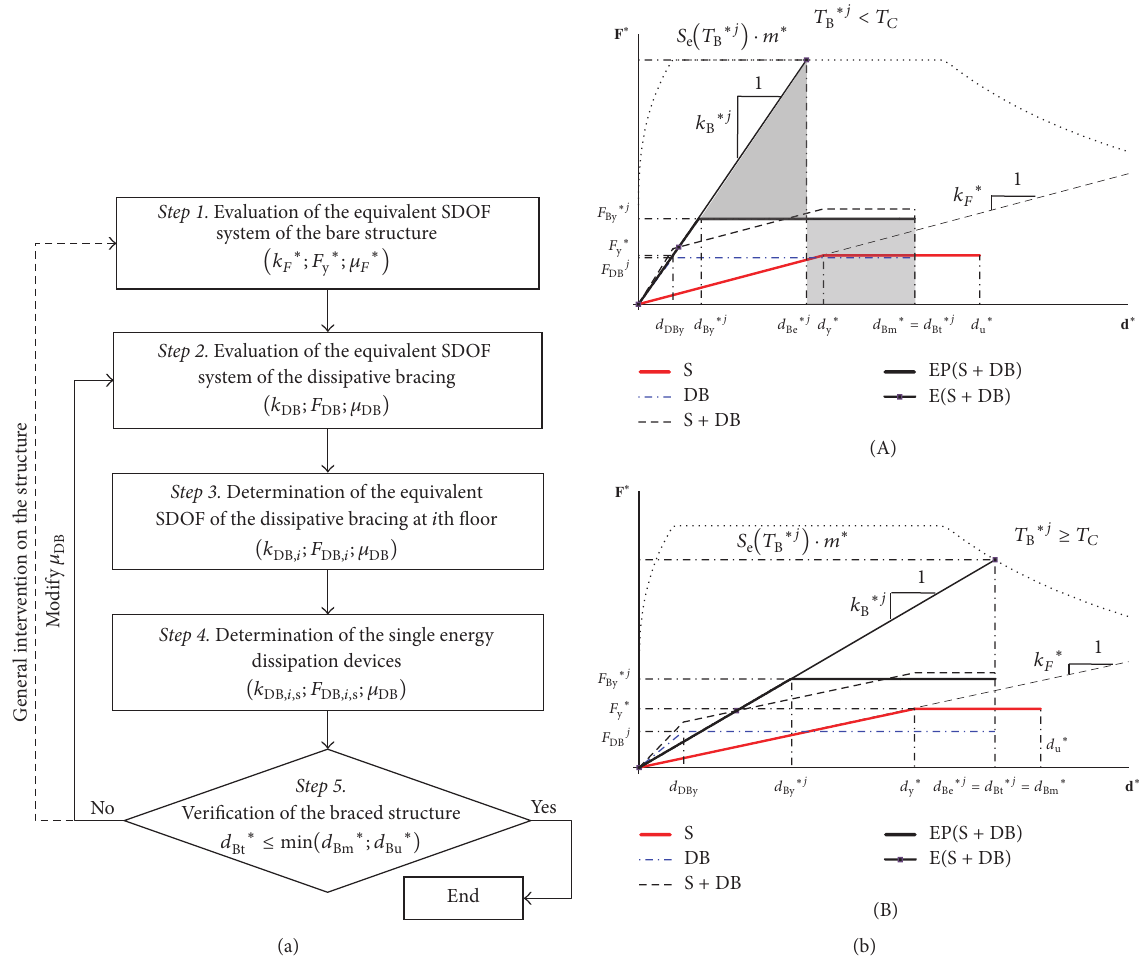
Figure 1: (a) Design procedure; (b) Step 2 for (A) short-period range; (B) medium/long-period